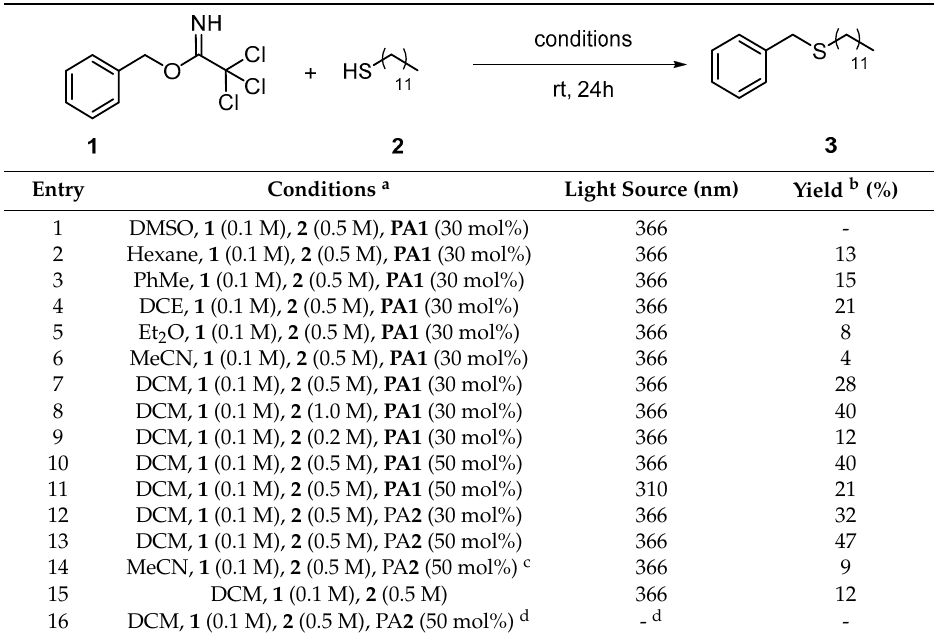
Table 1. Acid catalyzed synthesis of benzylsulfide 3 .